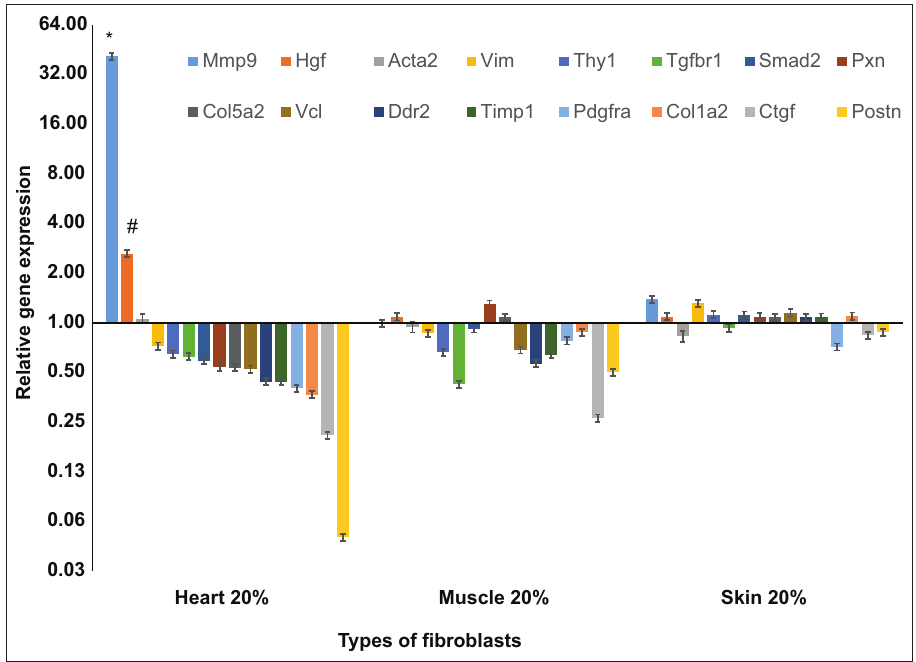
Figure-8: Fibrotic gene expression in 20% serum culture compared among three types of fibroblasts. The expression was calculated relative to 10% serum culture (control) and gene expression was relative to control culture (10% serum). Cardiac fibroblasts were more sensitive to increased serum concentration than skin and muscle fibroblasts. *The expression of most fibrotic genes from cardiac fibroblasts was reduced. Matrix metallopeptidase 9 and hepatocyte growth factor expression was significantly elevated (*p<0.01 and # p<0.05). Cell culture was done in six replications, while quantitative polymerase chain reaction was done in three